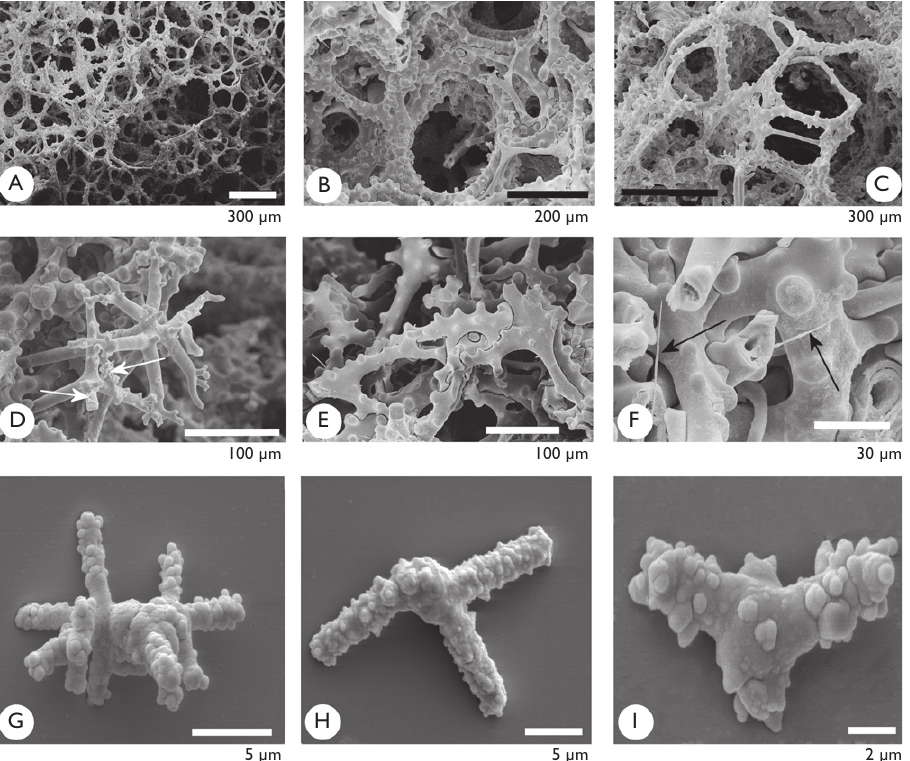
Fig. 2. Neophrissospongia nana nov. sp., holotype MSNG 54599, photomicrographs of the skeletal ar- chitecture and spicular complement. A-C. Subectosomal skeletal network of dicranoclone desmas. D. Dichotriaene (top) and simple triaene (bottom, arrows) radially arranged in the ectosome with tubercled cladomes. E. Articulation among desmas with scattered styles/sub-tylostyles in the sub-ectosome. F. Detail showing the arrangement of silica in dicranoclone desmas (cross section) and styles/sub-tylostyles (ar- rows). G-I. Streptaster/amphiaster microscleres with